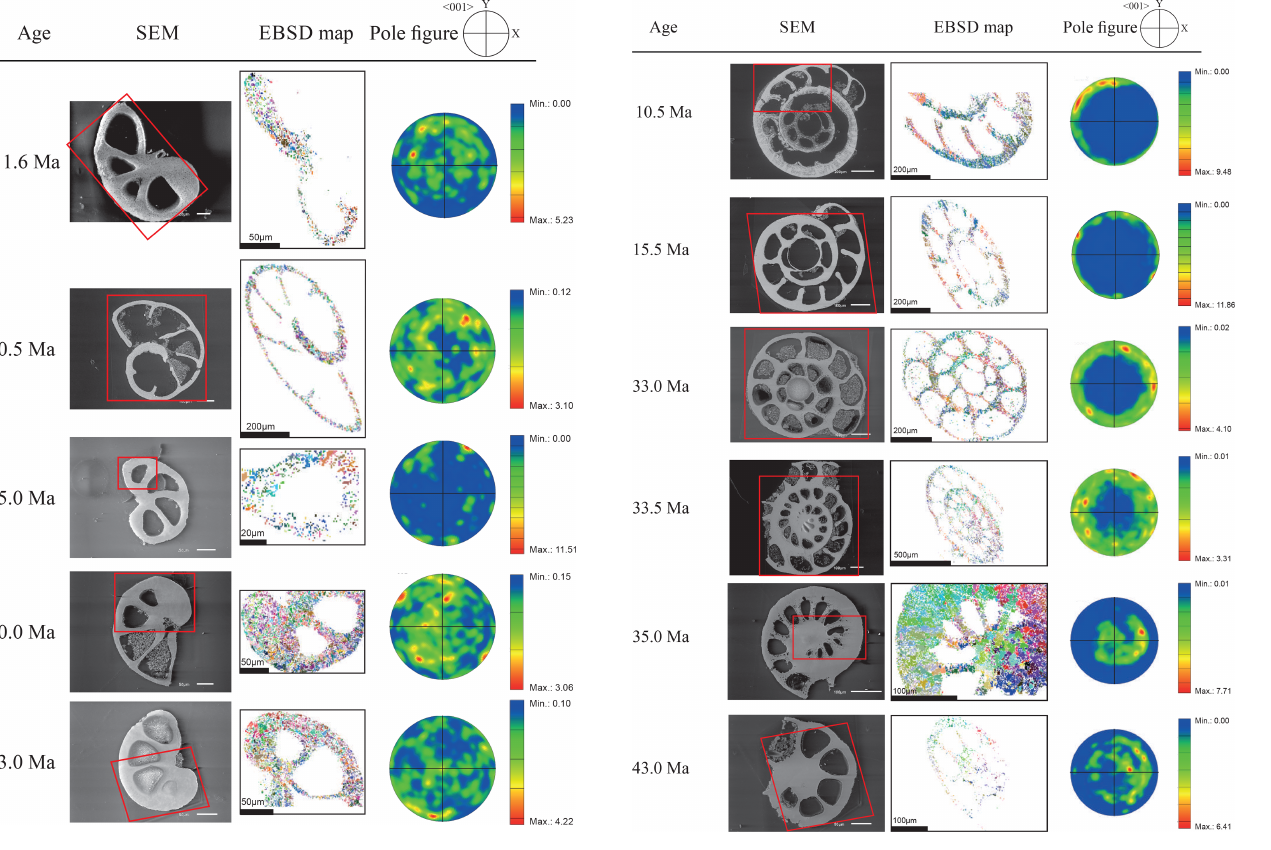
Figure 4. EBSD analysis of Cibicidoides grimsdalei tests from the Pacific equatorial region. Left: SEM images of the analysed specimens. Middle: EBSD maps displaying crystal orientations in colour-coded Euler angles. Right: pole plot figures showing cluster density of the c axes in contouring pole figures, half-width: 10 ◦ , Cluster size: 5 ◦ . The figure displays a clear distribution of the c axis within the x – y plane at 10.5 and 15.5Ma. At 33 and 33.5Ma, the preferred orientation of the c axis broadens but is still centred on the x – y plane. At 35 and 43Ma, orientation apparently shifts towards the z